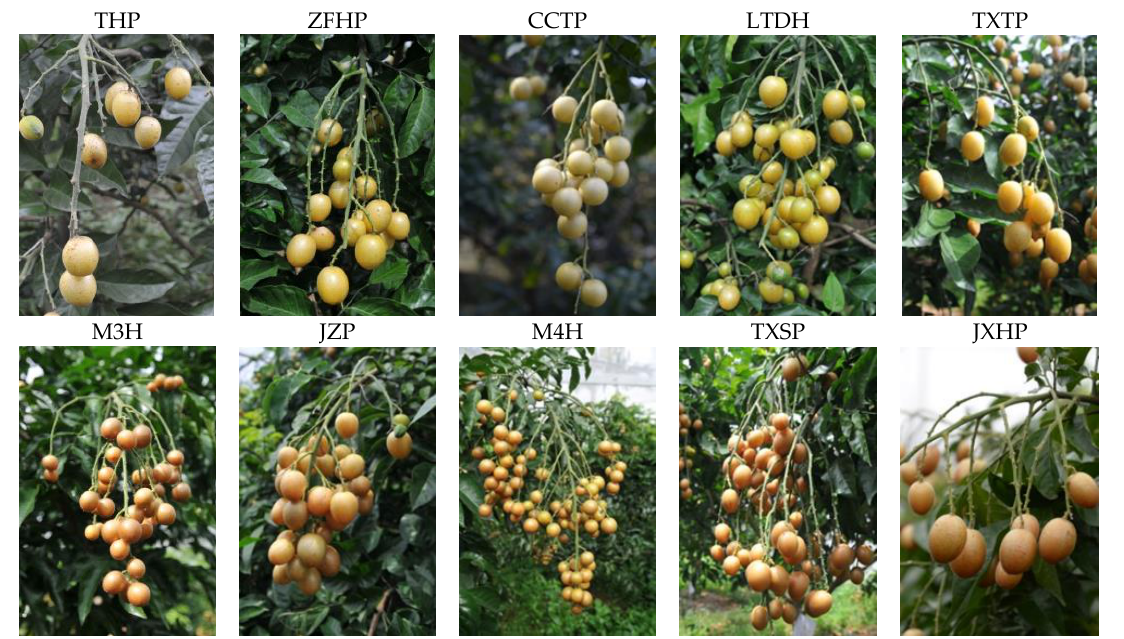
Figure 1. The varieties of wampee fruits. THP: TianHuangPi; ZFHP: ZaoFengHuangPi; CCTP: CongChengTianPi; LTDH: LuTianDuHe; TXTP: TaXiaTianPi; M3H: Min3Hao; JZP: JiZiPi; M4H: Min4Hao; TXSP: TaXiaSuanPi; JXHP: